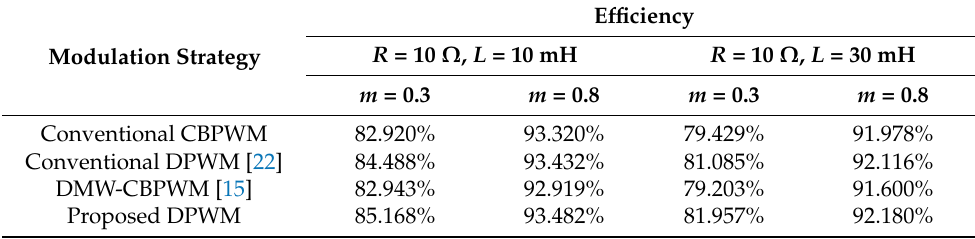
Table 7. The efficiency of the inverter under different